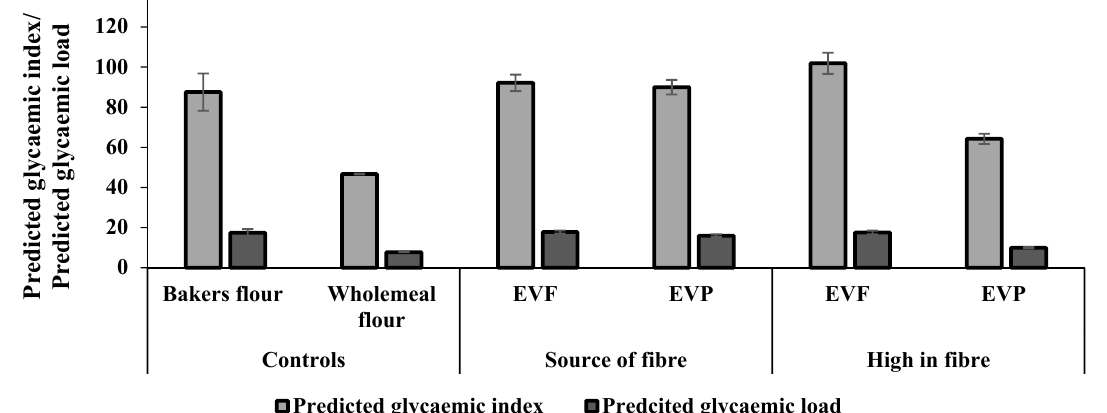
Figure 7. The predicted glycaemic index/glycaemic load of bread samples. EVF refers to EverVita FIBRA, while EVP represents EverVita PRO. SF and HF indicate the addition level of EverVita ingredients at ‘source of fibre’ and ‘high in fibre’, respectively.